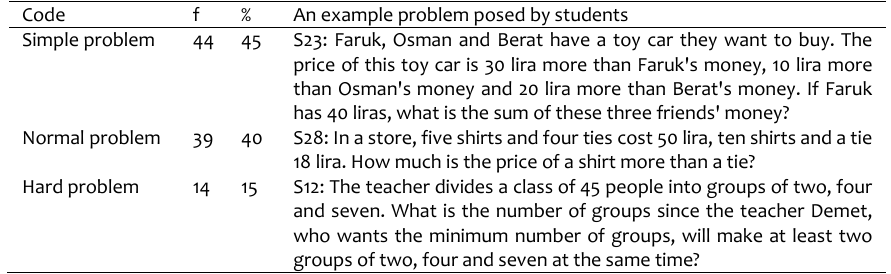
Table 6. Examination of the problems in terms of